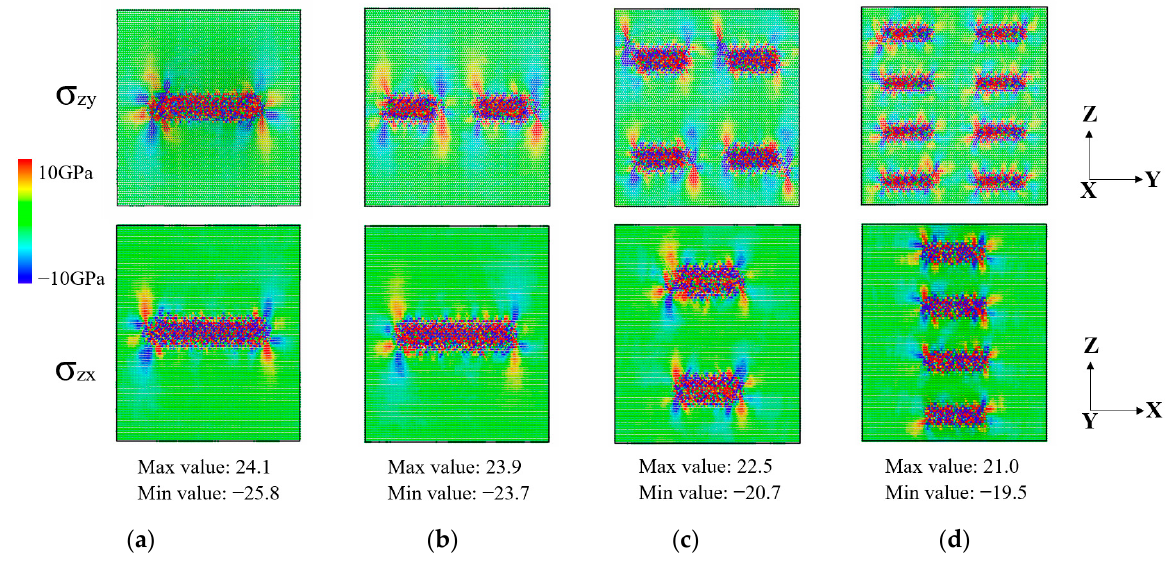
Figure 12. Contours of stress components at strain 0.068 (the top is σ zy , the bottom is σ zx ) ( a ) 1 precipitate; ( b ) 2 precipitates; ( c ) 4 precipitates; ( d ) 8 precipitates.